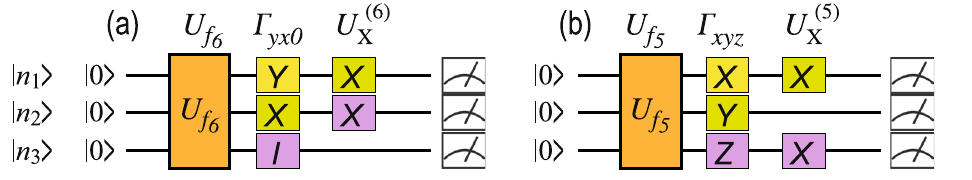
Figure 2. Quantum circuits determining c j . We show an example with ( a ) Ŵ yx 0 = σ y ⊗ σ x ⊗ σ 0 . U ( 6